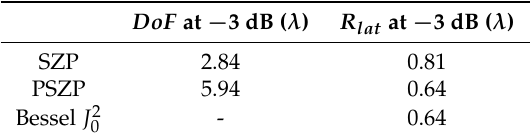
Table 1. DoF at − 3 dB and R lat at − 3 dB, comparison of the numerical